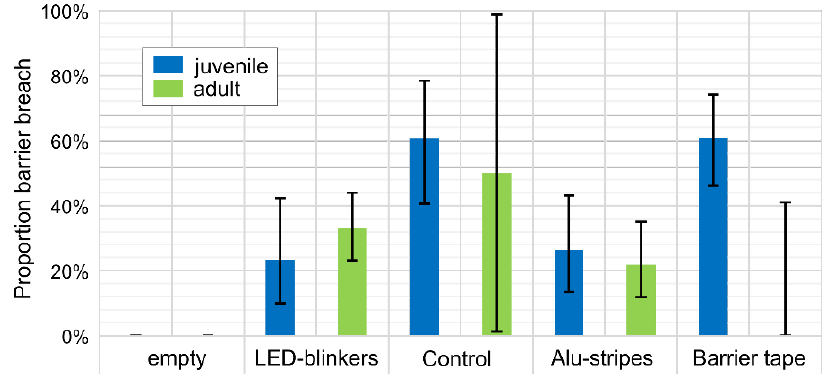
Figure 3. Proportion of barrier breaches with physical deterrence and 95% confidence intervals.